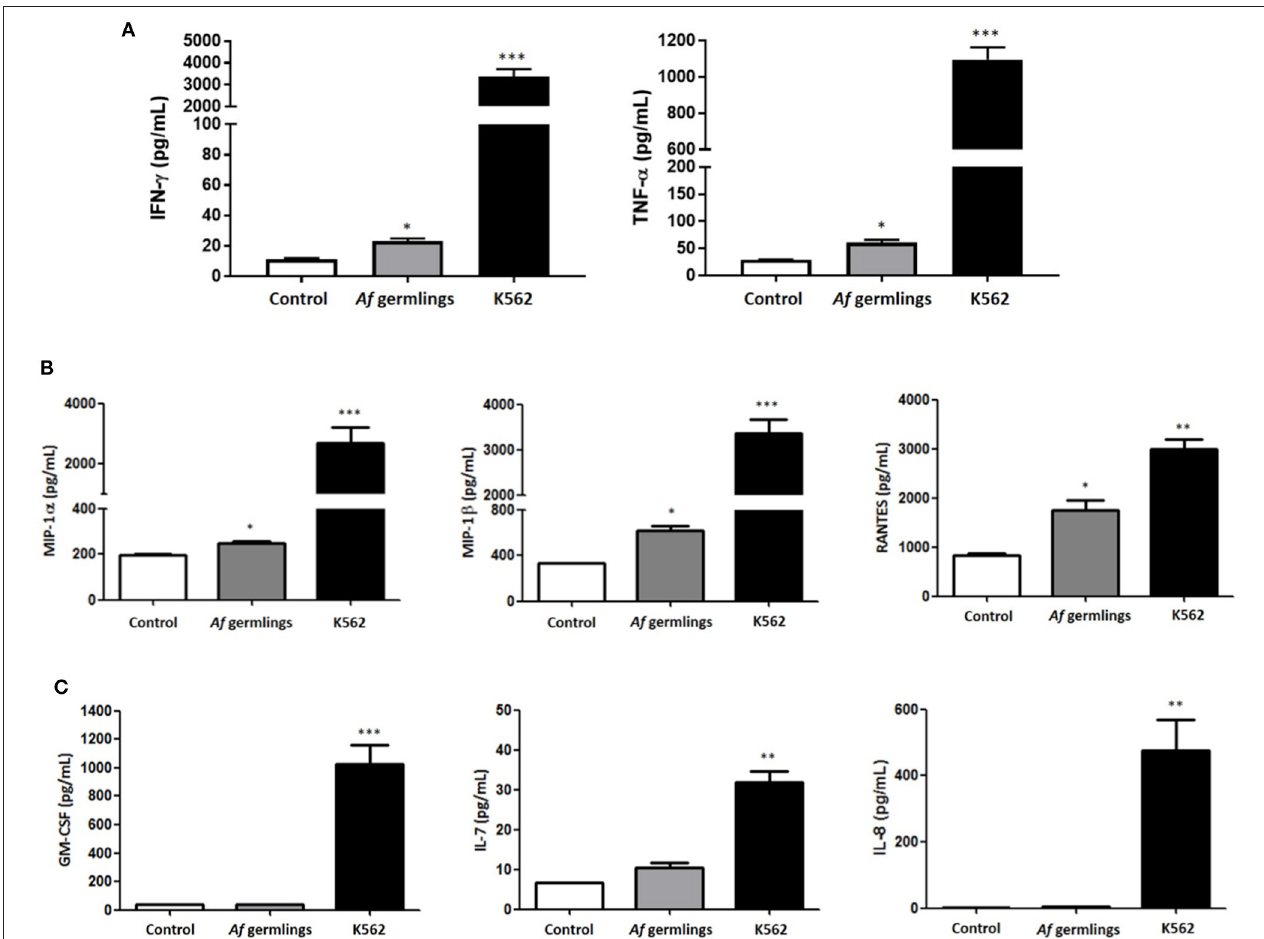
FIGURE 1 | Primary human NK cells secrete IFN- γ , TNF- α , MIP-1 α , MIP-1 β , and RANTES in response to A. fumigatus germlings (A) . Analysis of cytokine production by NK cells in response to A. fumigatus. Primary human NK cells were incubated overnight with A. fumigatus germlings at MOI = 1 in the presence of IL-2. Co-incubation with K562 cell line at MOI 1 was used as positive control. IFN- γ and TNF- α levels were determined in the supernatant of co-cultures by Luminex multiplex assay. Bar graphs show the mean + SEM of IFN- γ and TNF- α production. Statistical analysis was performed using the Student’s unpaired t -test. * p < 0.05, *** p < 0.001. (B) NK cells produce MIP-1 α , MIP-1 β , and RANTES in response to A. fumigatus germlings in the presence of IL-2. Primary human NK cells were incubated overnight with A. fumigatus germlings at MOI = 1 in the presence of IL-2. Co-incubation with K562 at MOI = 1 was used as positive control. MIP-1 α , MIP-1 β , and RANTES levels were determined in the supernatant of co-cultures by Luminex multiplex assay. Bar graphs show the mean + SEM of MIP-1 α , MIP-1 β , and RANTES production. Statistical analysis was performed using the Student’s unpaired t -test. * p < 0.05, ** p < 0.01, *** p < 0.001. n = 3 (C) . Analysis of GM-CSF, IL-7, and IL-8 production in response to A. fumigatus . Primary human NK cells were incubated overnight with A. fumigatus germlings at MOI = 1 in the presence of IL-2. Co-incubation with K562 at MOI = 1 was used as positive control. GM-CSF, IL-7, and IL-8 levels were determined in the supernatant of co-cultures by Luminex multiplex assay. Bar graphs show the mean + SEM of GM-CSF, IL-7, and IL-8 production. Statistical analysis was performed using the Student’s unpaired t -test. * p < 0.05, ** p < 0.01, *** p < 0.001. n =